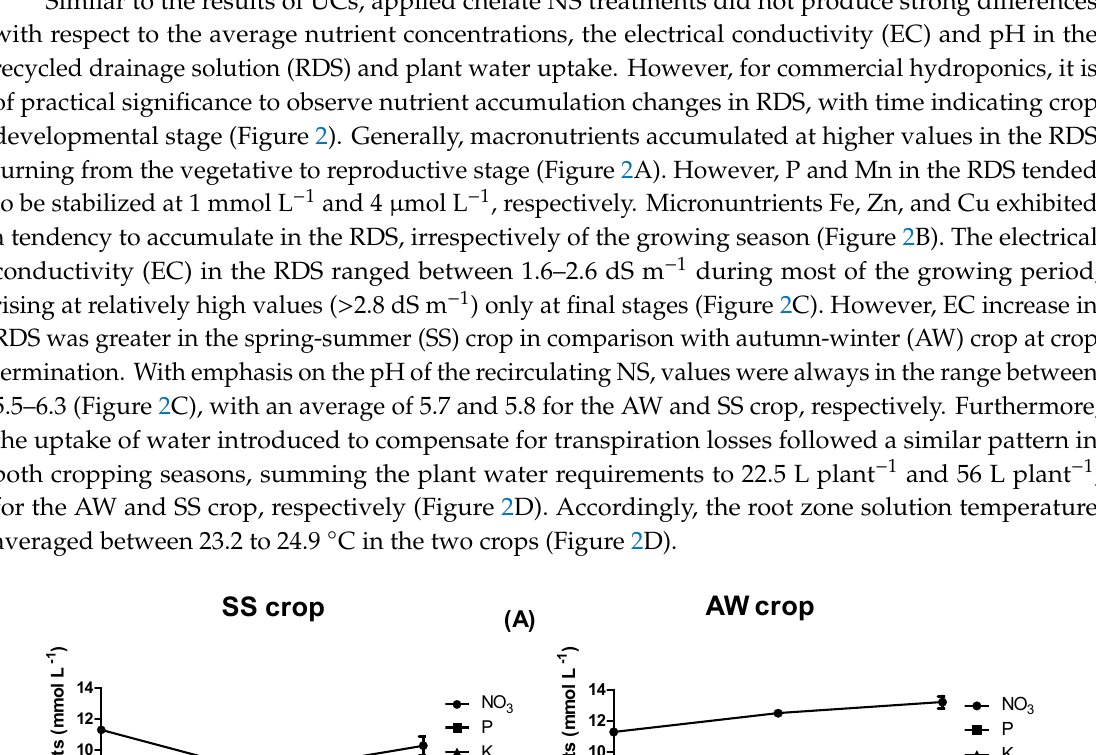
Figure 2. ( A ) Macro-(NO 3 , P, K, Ca and Mg; mmol L − 1 ) and ( B ) micronutrient (Fe, Mn, Zn and Cu; μ mol L − 1 ) concentrations, ( C ) electrical conductivity (EC; dS m − 1 ), pH and ( D ) root zone temperature (RZT; °C) in the recycled drainage solution and water uptake (L plant − 1 ) in two cropping seasons (spring-summer, SS crop; autumn-winter, AW crop) of hydroponic common bean, in relation with time indicating growth stages (Vegetative and Reproductive). Values are means calculated across treatments and vertical bars indicate ± standard errors of means (not shown when smaller than the symbol).